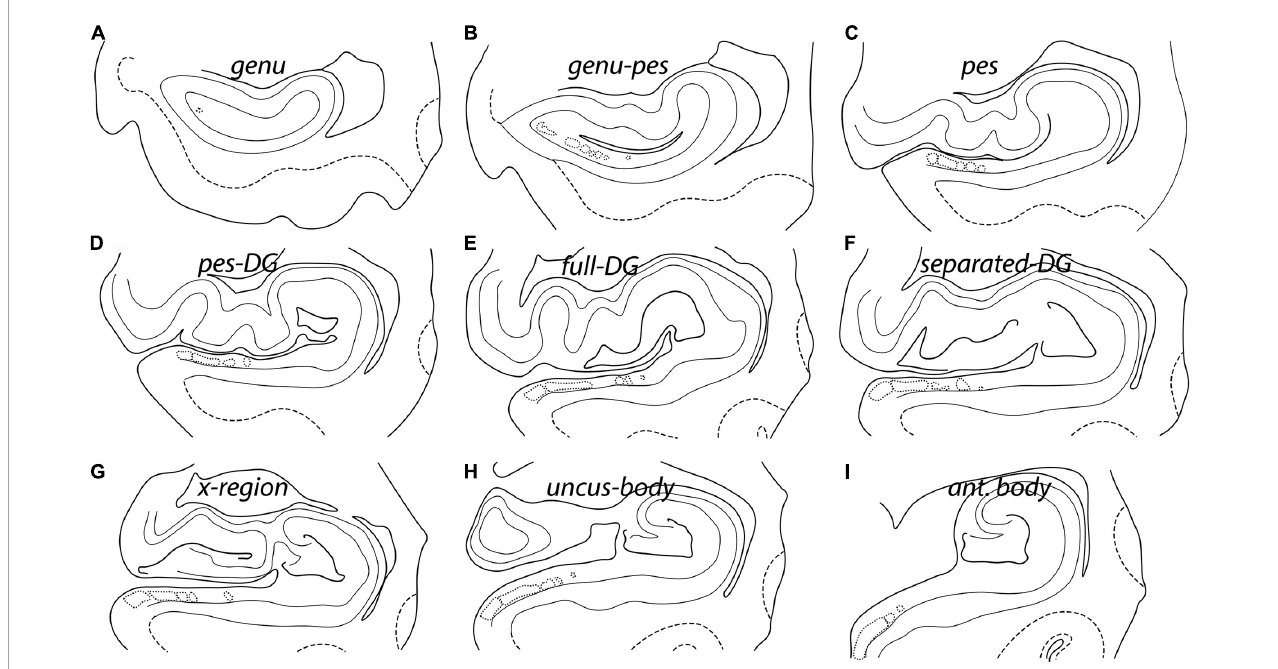
FIGURE1 Nine rostrocaudal hippocampal levels represented by line drawing schemata in the coronal plane. Each level shows different landmarks that makes it unique. Accordingly, each anterior-posterior level has been given a unique name: (A) Genu, (B) genu-pes, (C) pes, (D) pes-DG, (E) full DG, (F) separated DG, (G) x-region, (H) uncus-body, and (I) anterior body. The solid black lines represent the pial tissue surface and the dentate gyrus. The gray lines denote the gray-white matter boundaries, while the dashed lines indicate gray-white matter boundaries in the entorhinal cortex. The lightest gray lines depict the pyramidal layer, and dotted lines denote the presubicular clouds, LPE, and